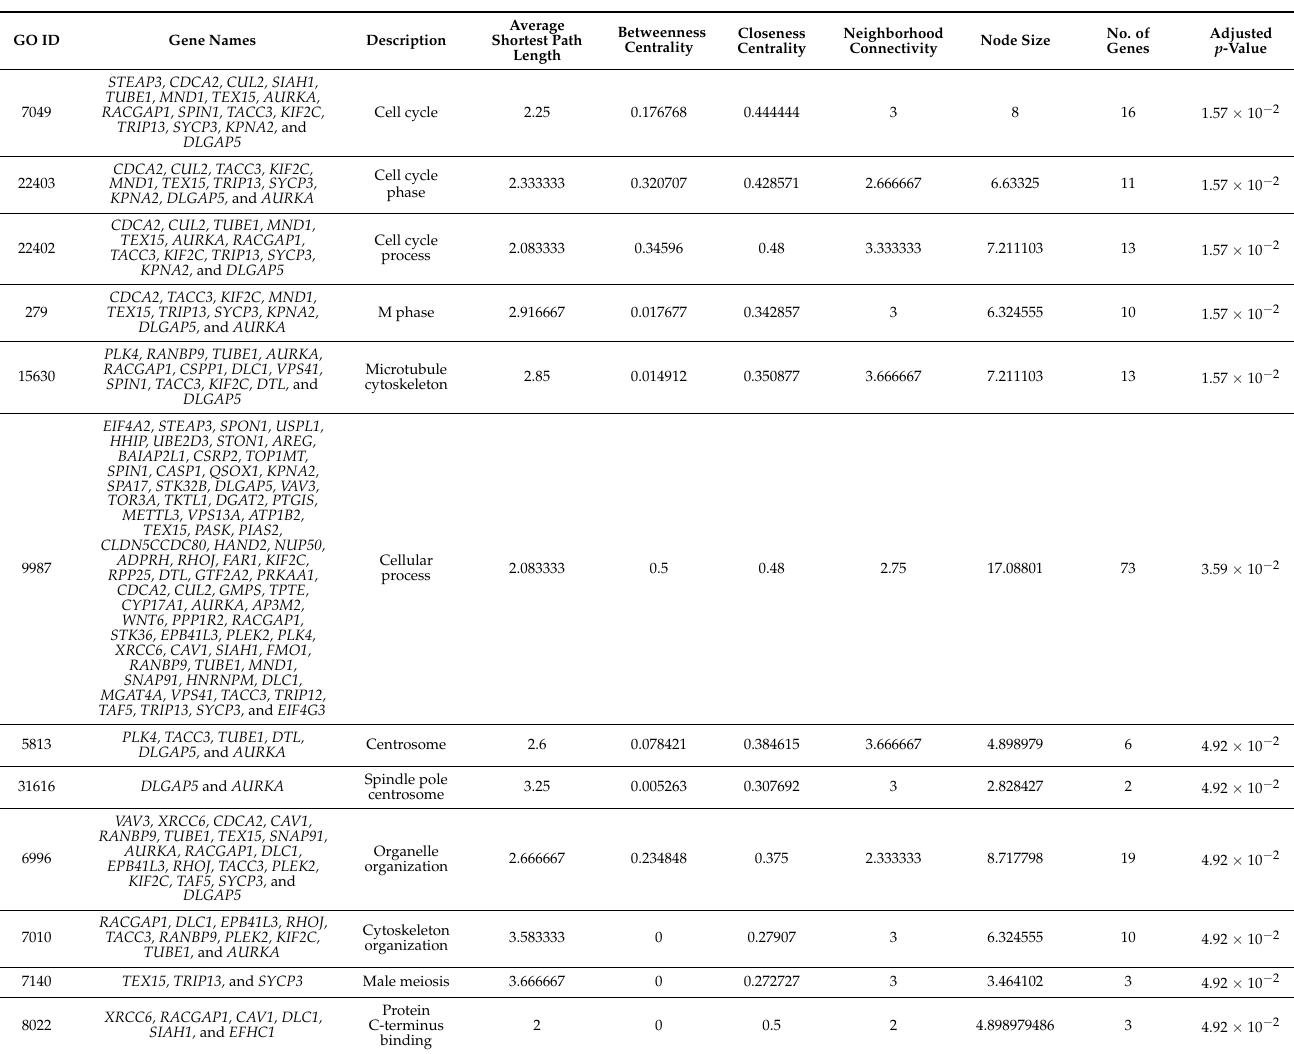
Table 4. List of top 12 significantly over-represented GO categories derived from the BINGO analysis output. The list has been prepared on the basis of ascending order of the adjusted p